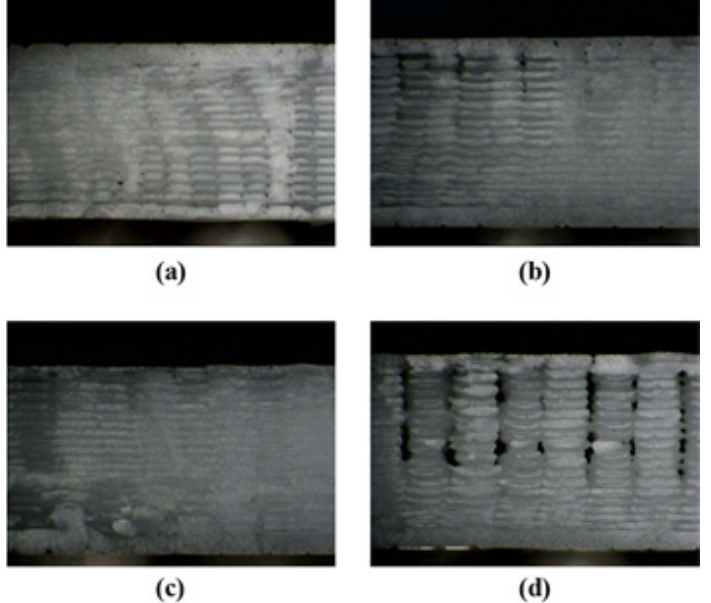
Figure 15. Microscopic images of fractured surface at raster widths of ( a ) 400 µm, ( b ) 500 µm, ( c ) 600 µm and ( d ) 700 µm Reprinted with permission from Ref. [92]. 2018, Elsevier.